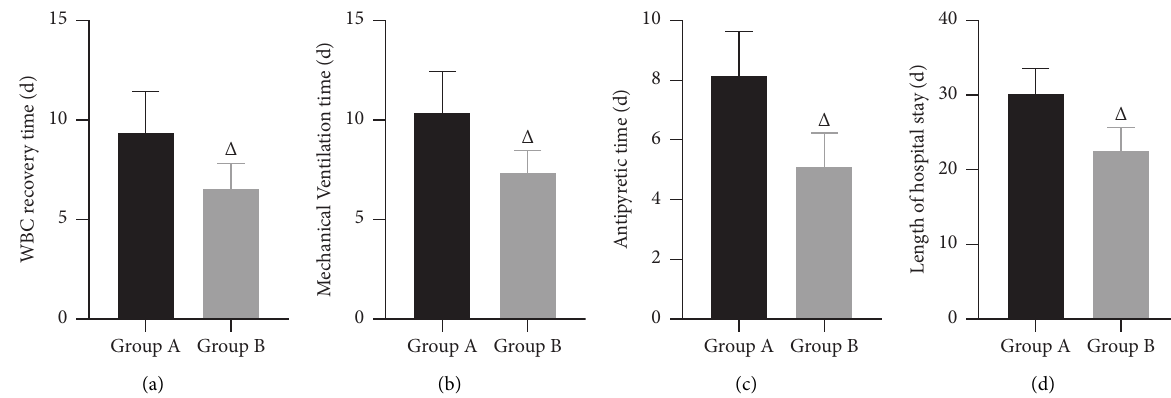
Figure 3: Relevant time indicators. Note . (a). WBC recovery time. (b). Mechanical ventilation time. (c). Antipyretic time. (d). Length of hospital stay. Comparison with group A, △ P < 0 . 05.